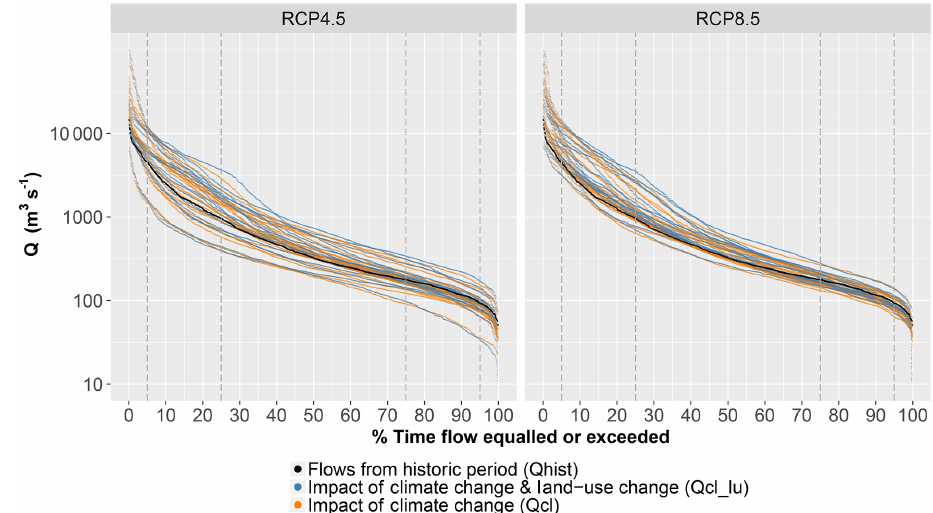
Figure B1. Flow duration curves of the streamflows simulated by JULES for the Upper Ganges basin, when forced by CMIP5 model outputs. Orange: only climate change is taken into account (Q cl ) ; simulation period 2030–2035; each line represents JULES outputs based on different CMIP5 model forcing. Blue: both climate change and land-use change are taken into account (Q cl_lu ) ; simulation period 2030–2035; each line represents JULES outputs based on different CMIP5 model forcing. Black: historical period (Q hist ) ; simulation period